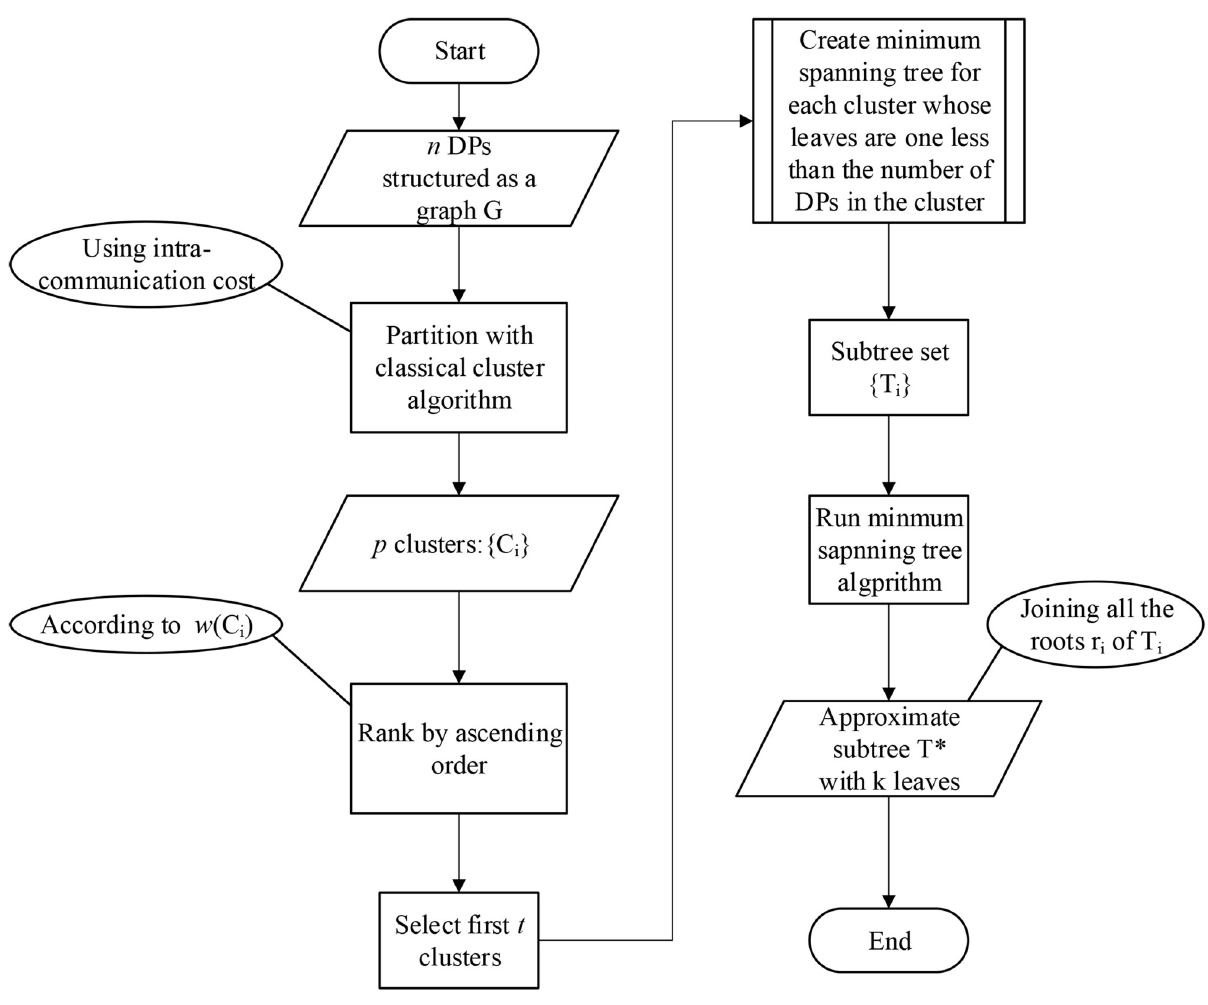
Fig 2. Workflow of Cluster-and-Union